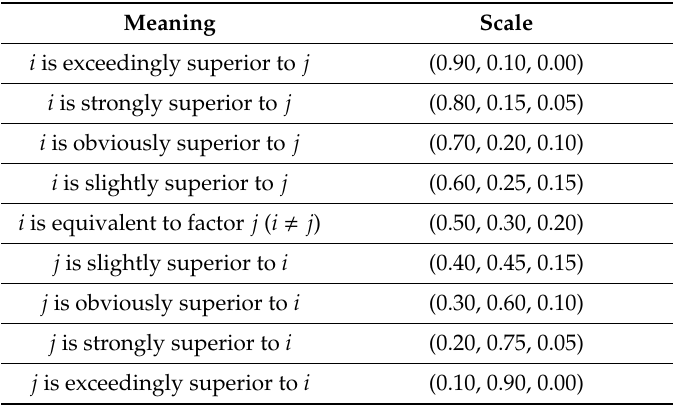
Table 5. Intuitionistic fuzzy scale of low-carbon sustainability and green operation benefits of power generation